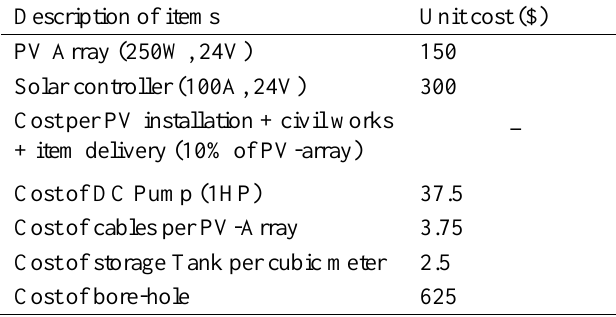
Technical and cost parameters of